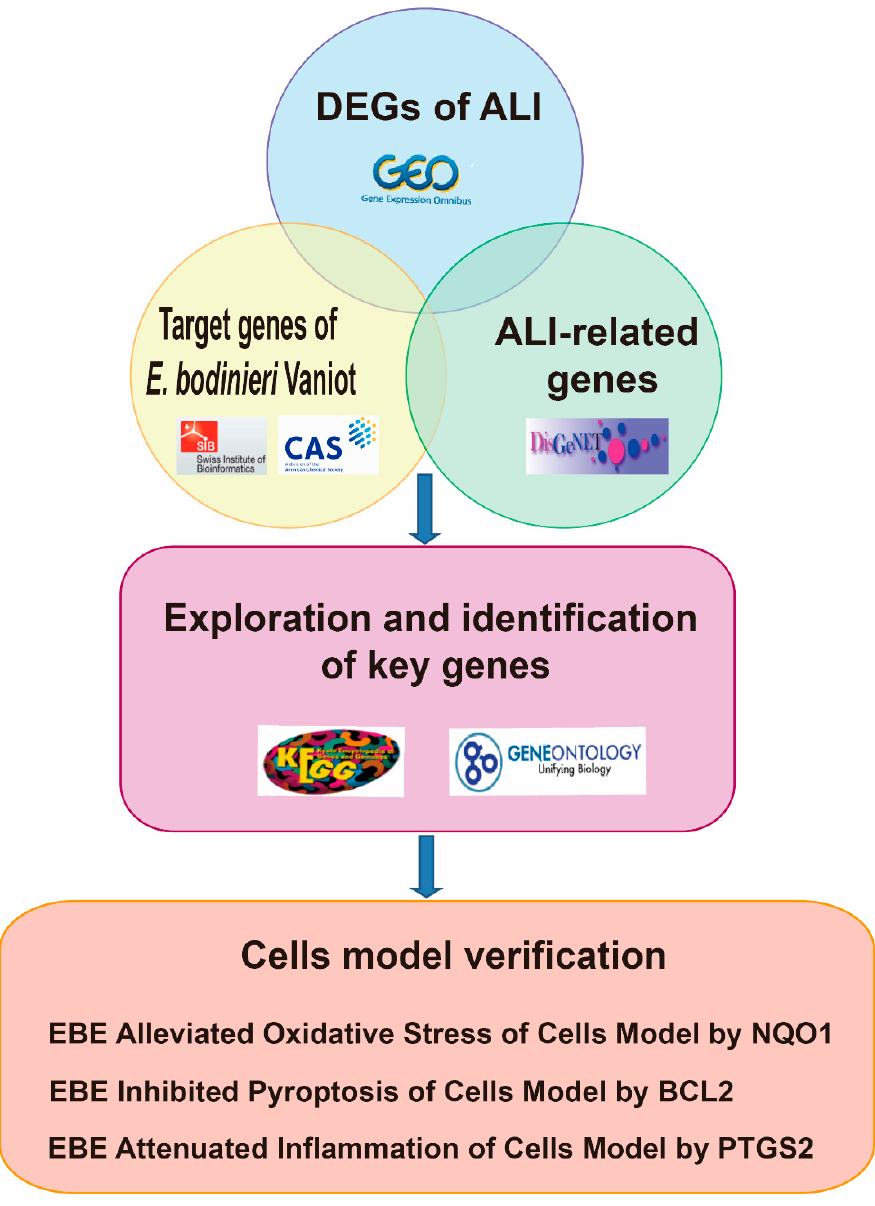
Figure 1. The bioinformatics and experiments workflow of E. bodinieri Vaniot ameliorate acute lung injury.